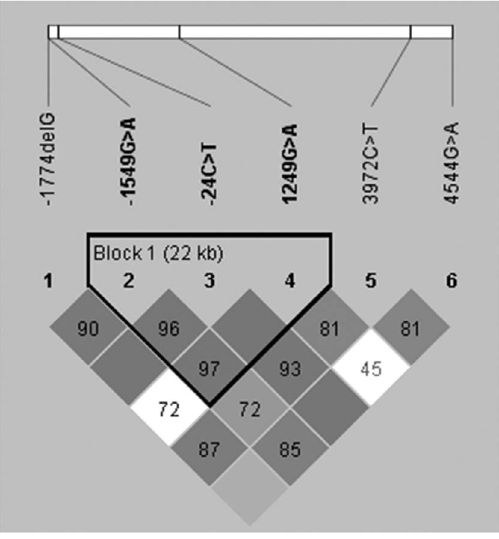
Figure 1. Linkage disequilibrium (LD) plot of ABCC2 polymor- phisms. Each square represents a pairwise LD relationship formed between the two single polymorphisms with D’ values multiplied by 100 shown inside the squares. The shade of grey indicates the degree of LD significance. Dark grey squares represent statistically significant LD as measured by D’ up to a maximum of 1. White squares indicate D’ values less than 1 with no statistically significant LD. The three polymorphisms -1549G . A, -24C . T and 1249G . A were found to form a separate haploblock with evidence of strong LD according to the Gabriel